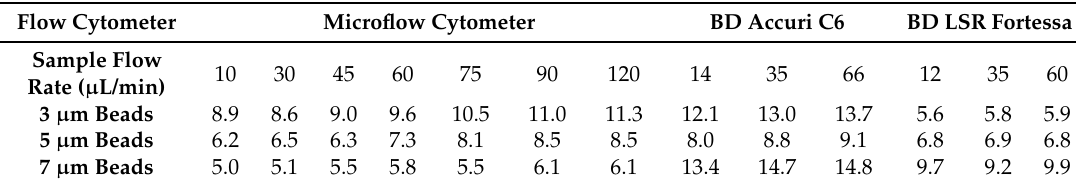
Table 1. Coefficient of variations (CVs) (%) of microbeads detected by the microflow cytometer and commercial instruments.